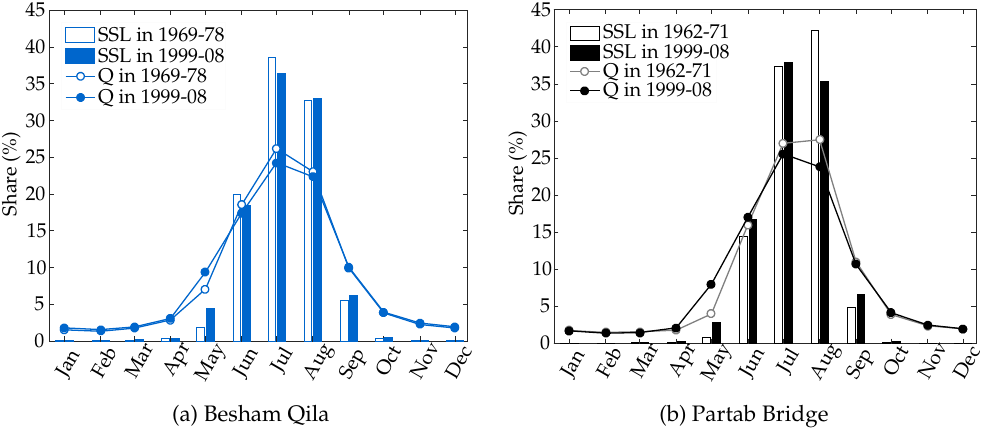
Figure 8. Monthly share of SSL and flow volume in the first and last decade of the analyzed record.